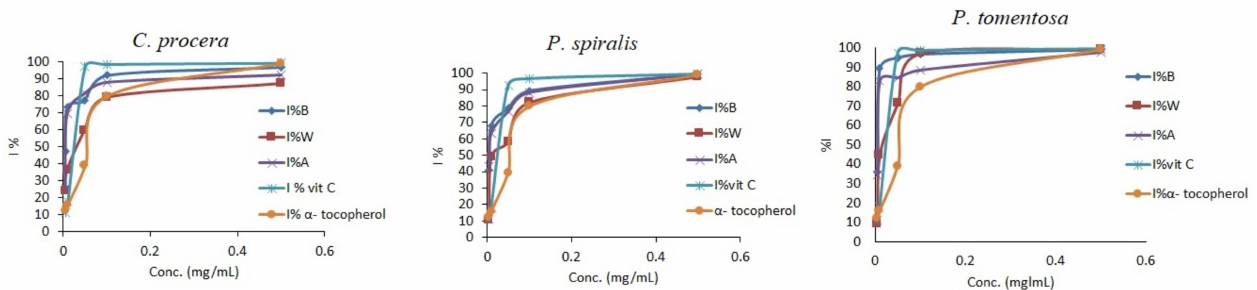
Figure 2. Antioxidant activity of crude extracts from C. procera , P. spiralis , and P. tomentosa and standards using the DPPH method. B = butanol extract, A = aq. MeOH extract, W = water extract.